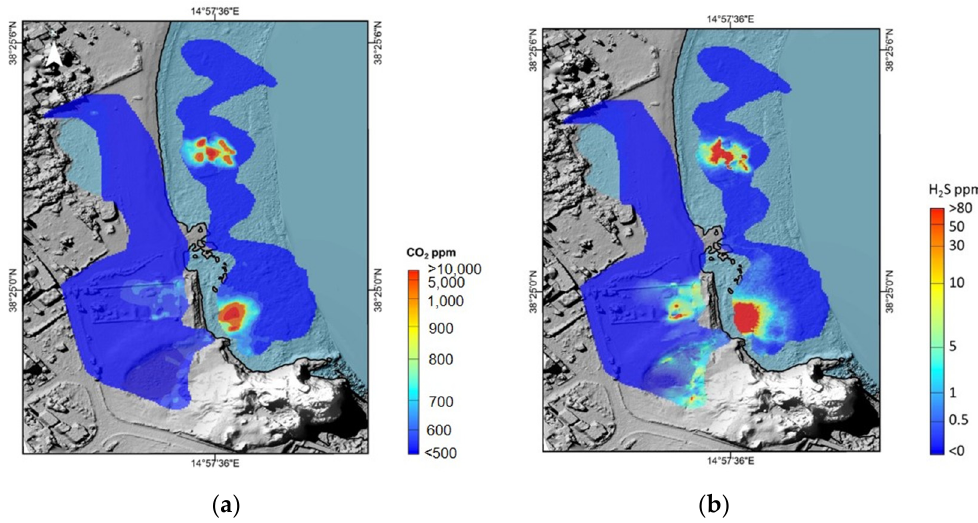
Figure 5. Maps derived from the interpolation of the datasets acquired by the Multi-GAS gas analyzer, reporting the atmospheric concentrations of CO 2 ( a ) and H 2 S ( b ).